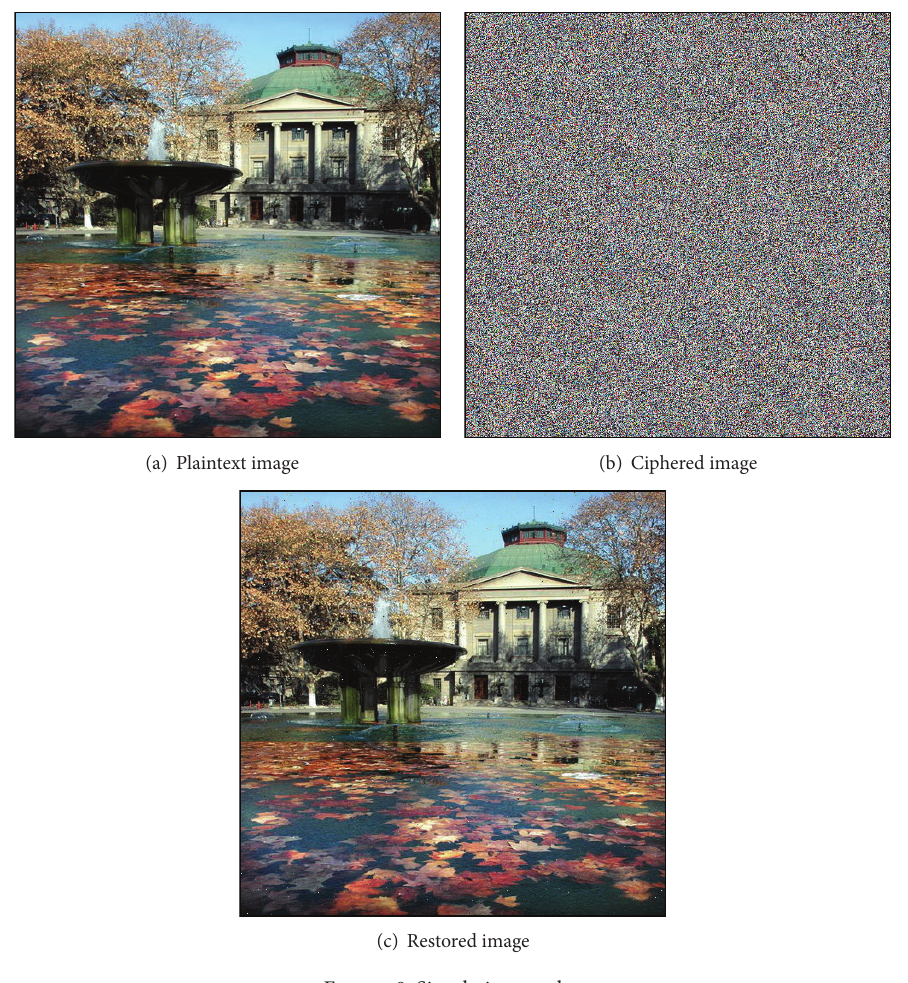
Figure 8: Simulation